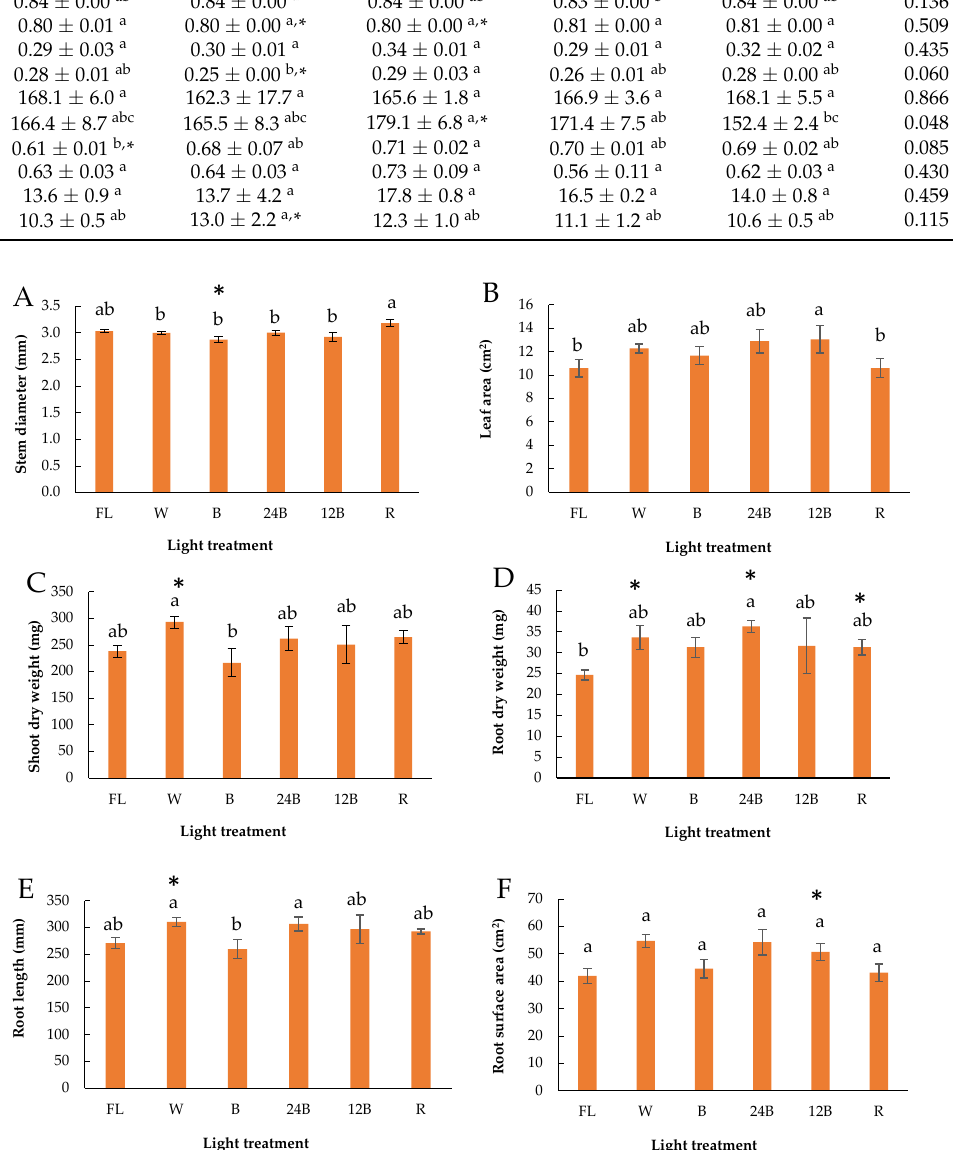
Table 2. Effect of light treatment on physiological parameters, biochemical compounds and calculated qualitative parameters of grafted tomato seedlings 7 and 14 days after transplantation. Fv/Fm: maximum quantum yield of primary photochemistry; TPC in mg/kg: total phenolic content; FRAP in µ g/g; ferric reducing antioxidant power; R/SA in g/cm 2 : root dry weight/surface area; %DWR: percentage of root dry weight; FL: fluorescent lamps; W: white; B: blue; 24B: 24% blue; 12B: 12% blue; R: red. Mean values followed by different letters are significantly different at p ≤ 0.05 according to the LSD method. Asterisks indicate significant differences between the LED treatments and the control (FL) at p ≤ 0.05 according to t -test. Fourteen days after transplantation, the stem diameter was significantly promoted under R compared to the rest of the light treatments, except for FL, while B showed lower values compared to FL according to the t -test (Figure 4A). 12B enhanced leaf area de- velopment compared to FL and R (Figure 4B). Shoot dry weight was enhanced by W than B, while the t -test also showed greater values for W compared to FL (Figure 4C). Root dry weight was greater under 24B compared to FL, while the t -test also showed greater val- ues for W, 24B and R compared to FL (Figure 4D). Roots were significantly longer in W and 24B compared to B (Figure 4E), while no significant differences were observed in the root surface area, except for the t -test, which showed greater values in 12B compared to FL (Figure 4F). Fv/Fm was not significantly different among the light treatments, but B and 24B had significantly lower values compared to FL according to the t -test (Table 2). The total phenolic compounds were greater under 24B and FL than B (Table 2), while the FRAP was enhanced under 24B compared to R and FL (Table 2). At 14 days, R/SA was not significantly affected, while the %DWR was significantly greater under B compared to FL (Table 2).